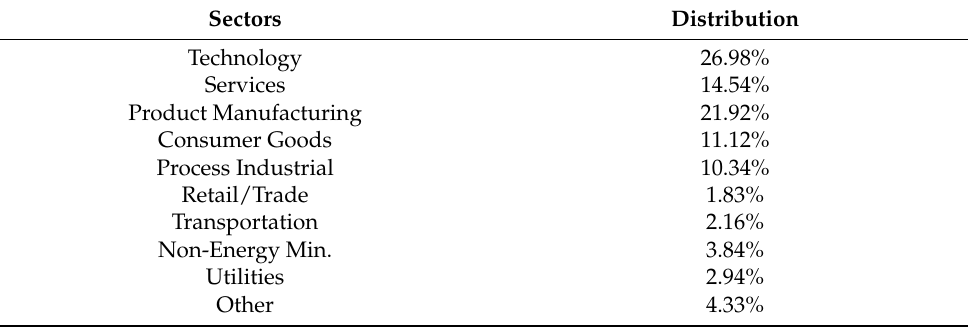
Table 1. Sample distribution in terms of sectors.